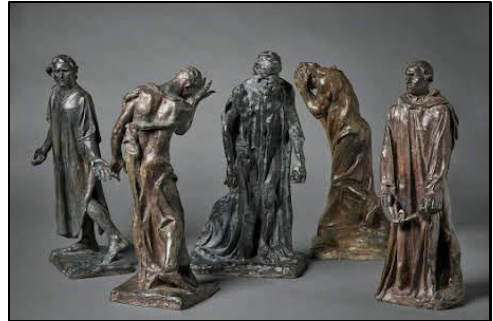
Figure 3. Rodin’s Burgher of Calais (1895).